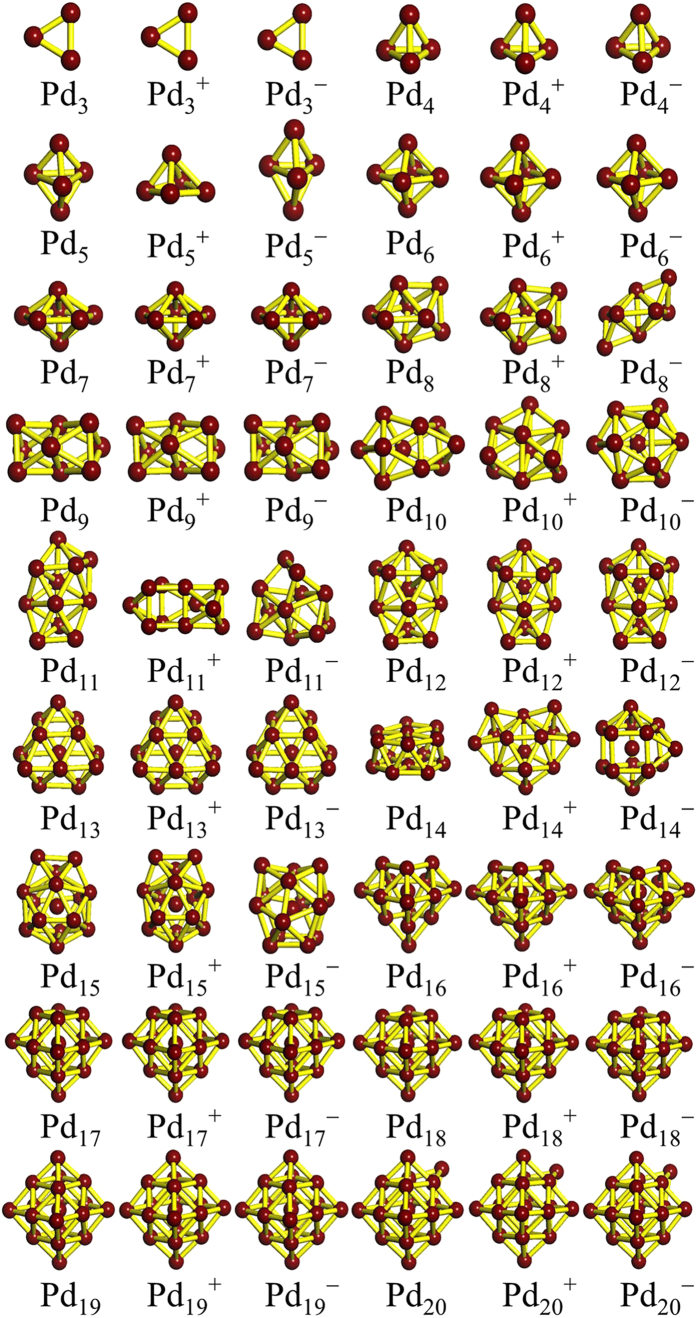
Lowest-energy structures of Pdn0/+/– (n = 3–20) clusters.